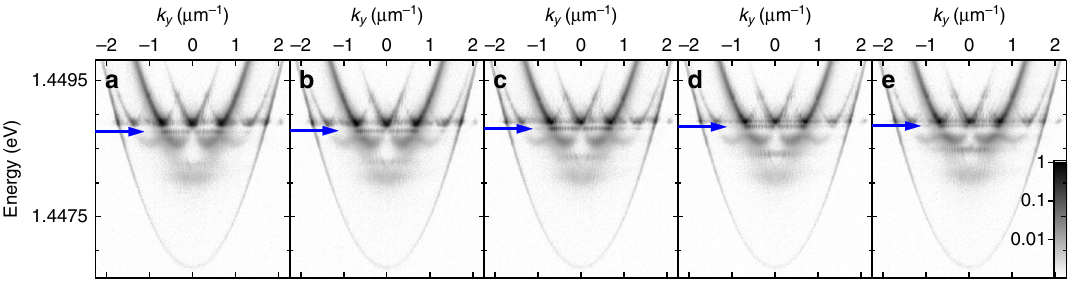
Fig. 5 Demonstration of control over the energy of a defect state through changing the size of the engineered defect. Experimental dispersions of the PL from chains of 12 polariton condensates with a ≈ 10 μ m and a defect length of a a d ≈ 9.0 μ m, b a d ≈ 8.6 μ m, c a d ≈ 8.2 μ m, d a d ≈ 7.6 μ m, and e a d ≈ 7.1 μ m. Each colourmap uses the normalised logarithmic colour scale shown in e . The gap mode is indicated by the blue arrows.